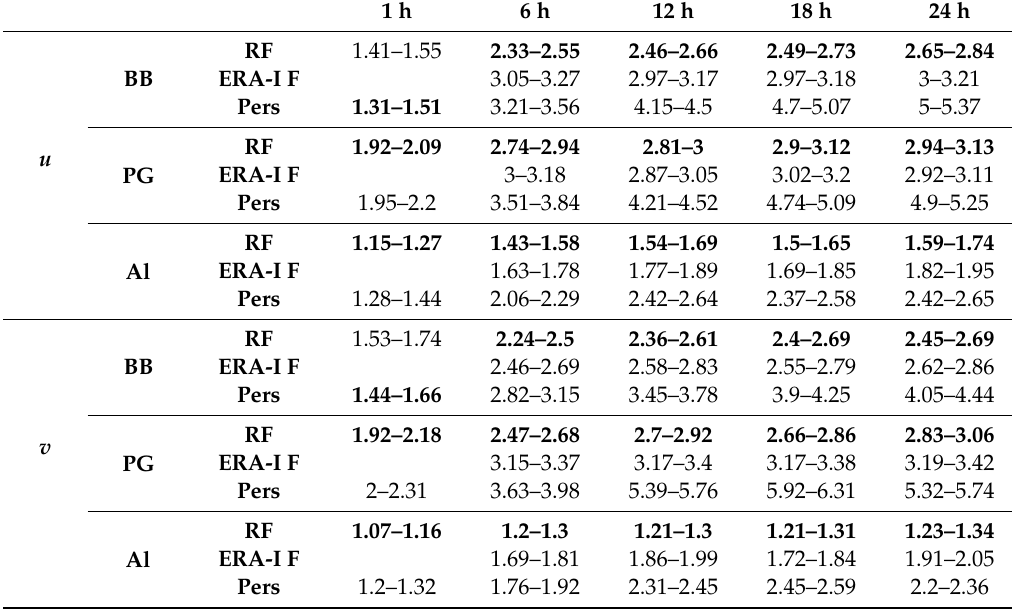
Table 6. RMSE index (95% confidence interval) of u and v wind components for the steps 1, 6, 12, 18, and 24 h, for three locations (Bilbao Bizkaia, Punta Galea, and Alegria), and RF, ERA-Interim forecasts, and persistence models. Lowest values of RMSE are highlighted by means of bold